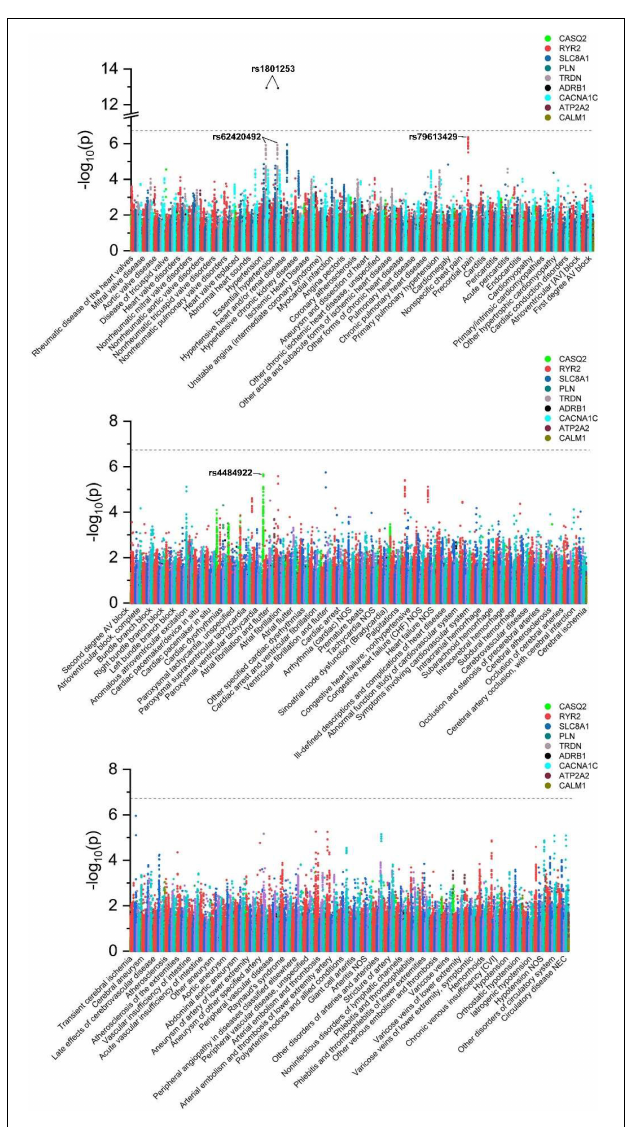
FIGURE 2 | Manhattan plots showing p -values of all tested associations between 11,274 genetic variants and 118 diseases of the circulatory system. The threshold indicating a significant level of association is marked by a dotted line. The leading SNPs of significant or suggestive genotype–phenotype associations are